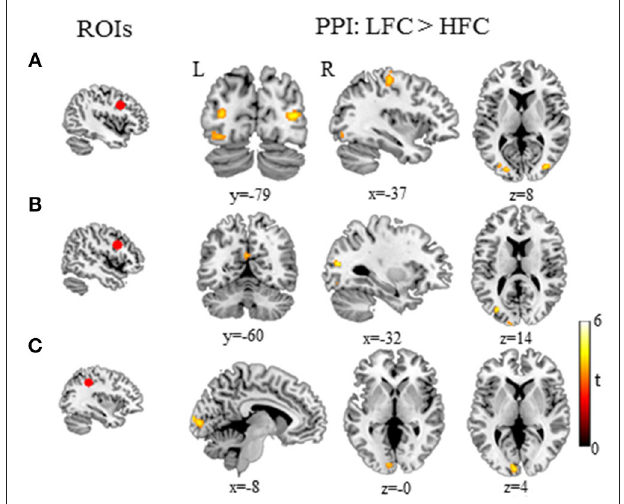
FIGURE 3 | Functional connections associated with the word-frequency effect (LFC > HFC) during Chinese writing. (A) Brain regions that increased functional connectivity with the left right superior frontal gyrus for LFC relative to HFC. (B) Brain regions that increased functional connectivity with the left inferior frontal gyrus for LFC relative to HFC. (C) Brain regions that increased functional connectivity with the left inferior parietal lobule for LFC relative to HFC. HFC, high-frequency characters; LFC, low-frequency characters; L, left; R, right.